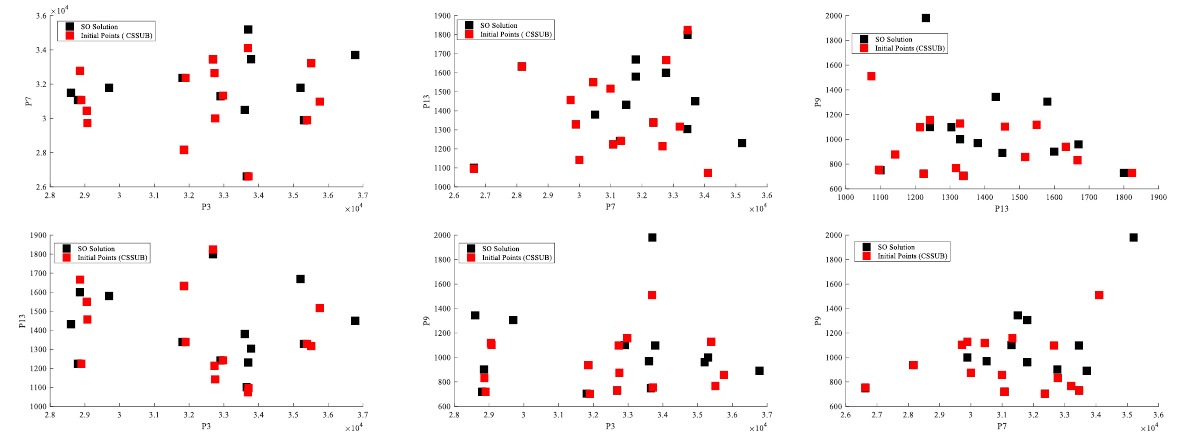
Fig. 9. Optimization of cluster centres by implementing SO